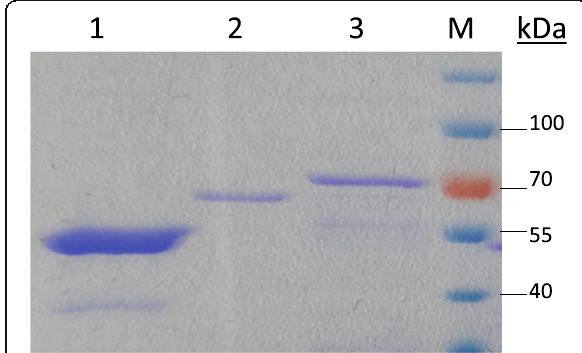
Fig. 2 SDS-PAGE analysis of His-taq-purified viral and bacterial chitinase proteins. Lane 1, S. marcescens -ChiC (50 kDa); lane 2, AcNPV-Chi (63 kDa); and lane 3, CpGV-Chi (68 kDa). M,